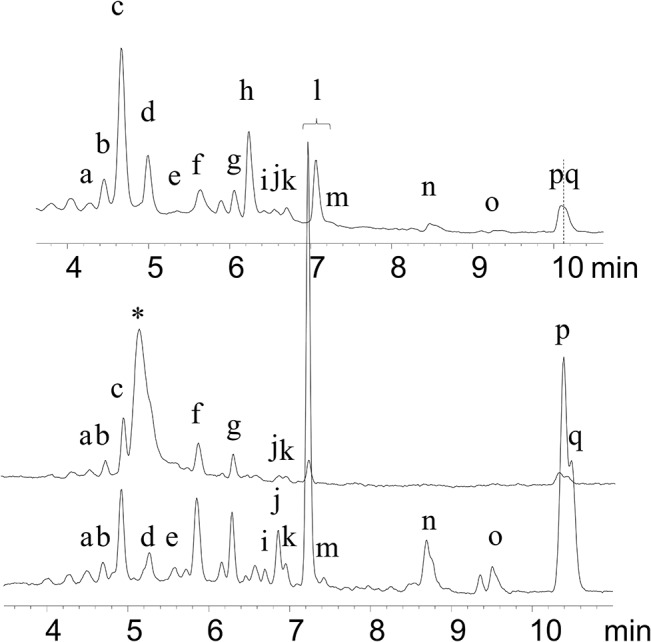
Chromatogram at 450 nm of carotenoids.Milk (top), neonatal plasma (middle), and maternal plasma (bottom) from the same family in the USA cohort at week 4. Peak identification: (a) 13- or 13’-cis-lutein (b) 13’- or 13-cis-lutein, (c) all-trans- lutein, (*) unidentified, (d) all-trans-zeaxanthin, (e) 9- or 9’-cis- lutein, (f) α-cryptoxanthin, (g) β-cryptoxanthin, (h) echinenone internal standard,(i) 15-cis-β-carotene, (j) 13-cis-β- carotene, (k) α-carotene, (l) all-trans-β- carotene, (m) 9-cis-β-carotene, (n,o) cis-lycopene isomers, (p) all-trans-lycopene, (q) 5-cis-lycopene.